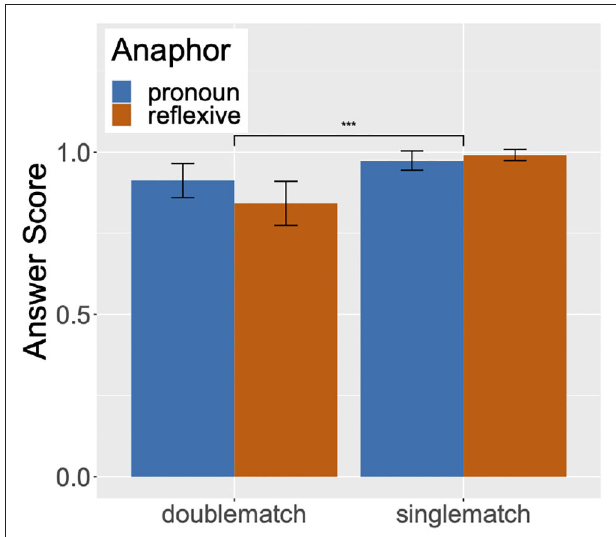
FIGURE 1 | Mean answer scores corresponding to structurally accessible antecedent selection in single/double match conditions, Experiment